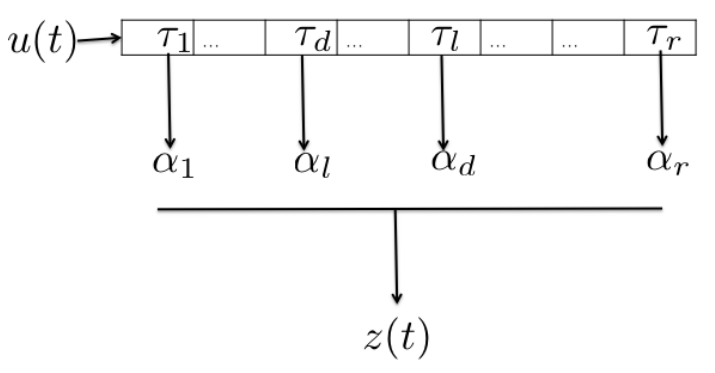
Figure 3. A realization of the UG channel model with three